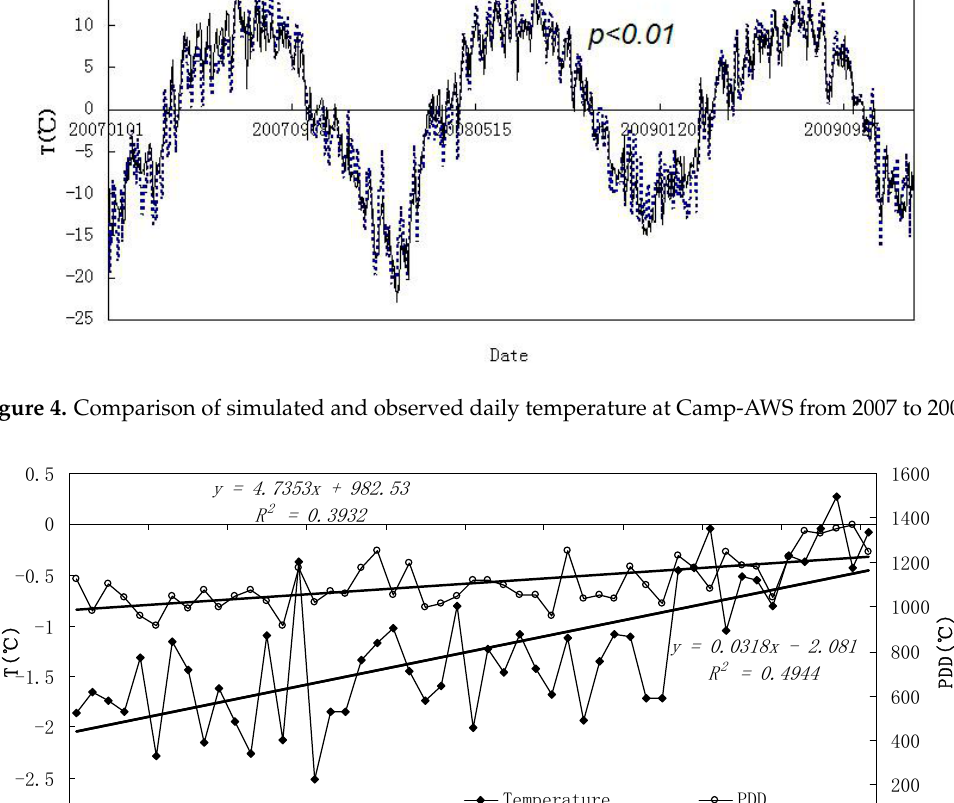
y = 0.0318x - 2.081 R 2 = 0.4944